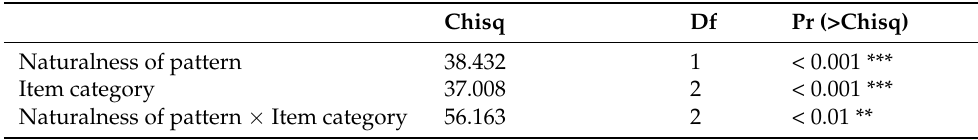
Table 8. Summary of the effects in the experiment (trained